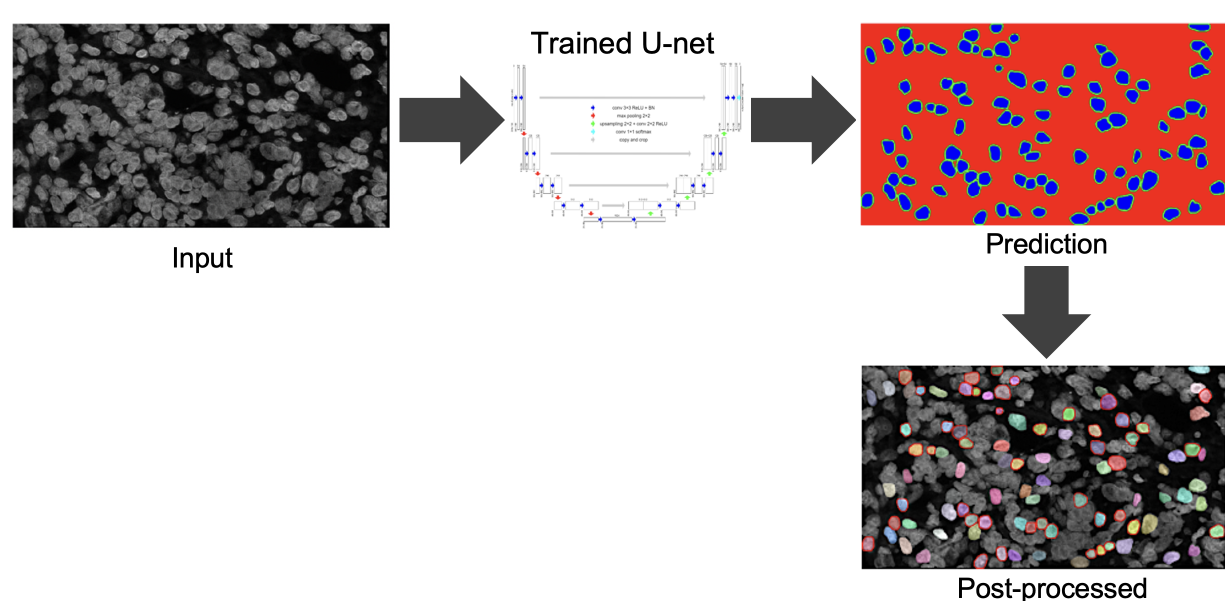
Figure 8. Overview of the training process.